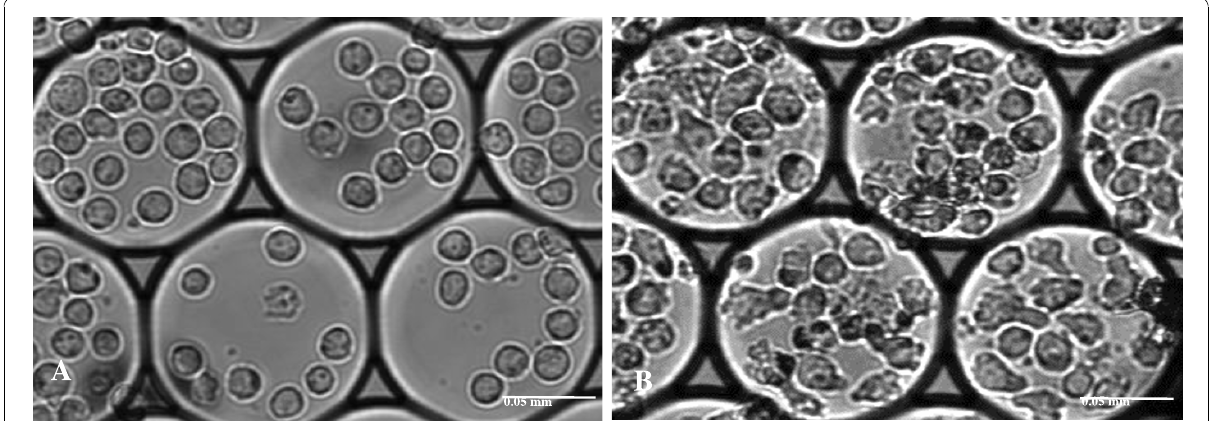
Figure 2 Cell proliferation after thawing . Bright field images of the cells (objective × 20) in the same individual picowells: A - immediately after the freezing - thawing cycle, B - following 48 hour culturing. Scale bar: 0.05